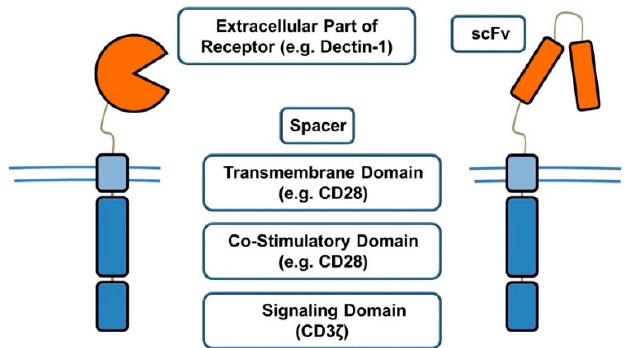
Figure 2. Second-generation chimeric antigen receptors (CARs) include a spacer, transmembrane domain, costimulatory domain, and signaling domain, as well as a targeting element. The two depicted CARs differ in their targeting element, which is usually the single chain variable fragment (scFv) of an antibody, but can also consist of the extracellular part of a receptor.